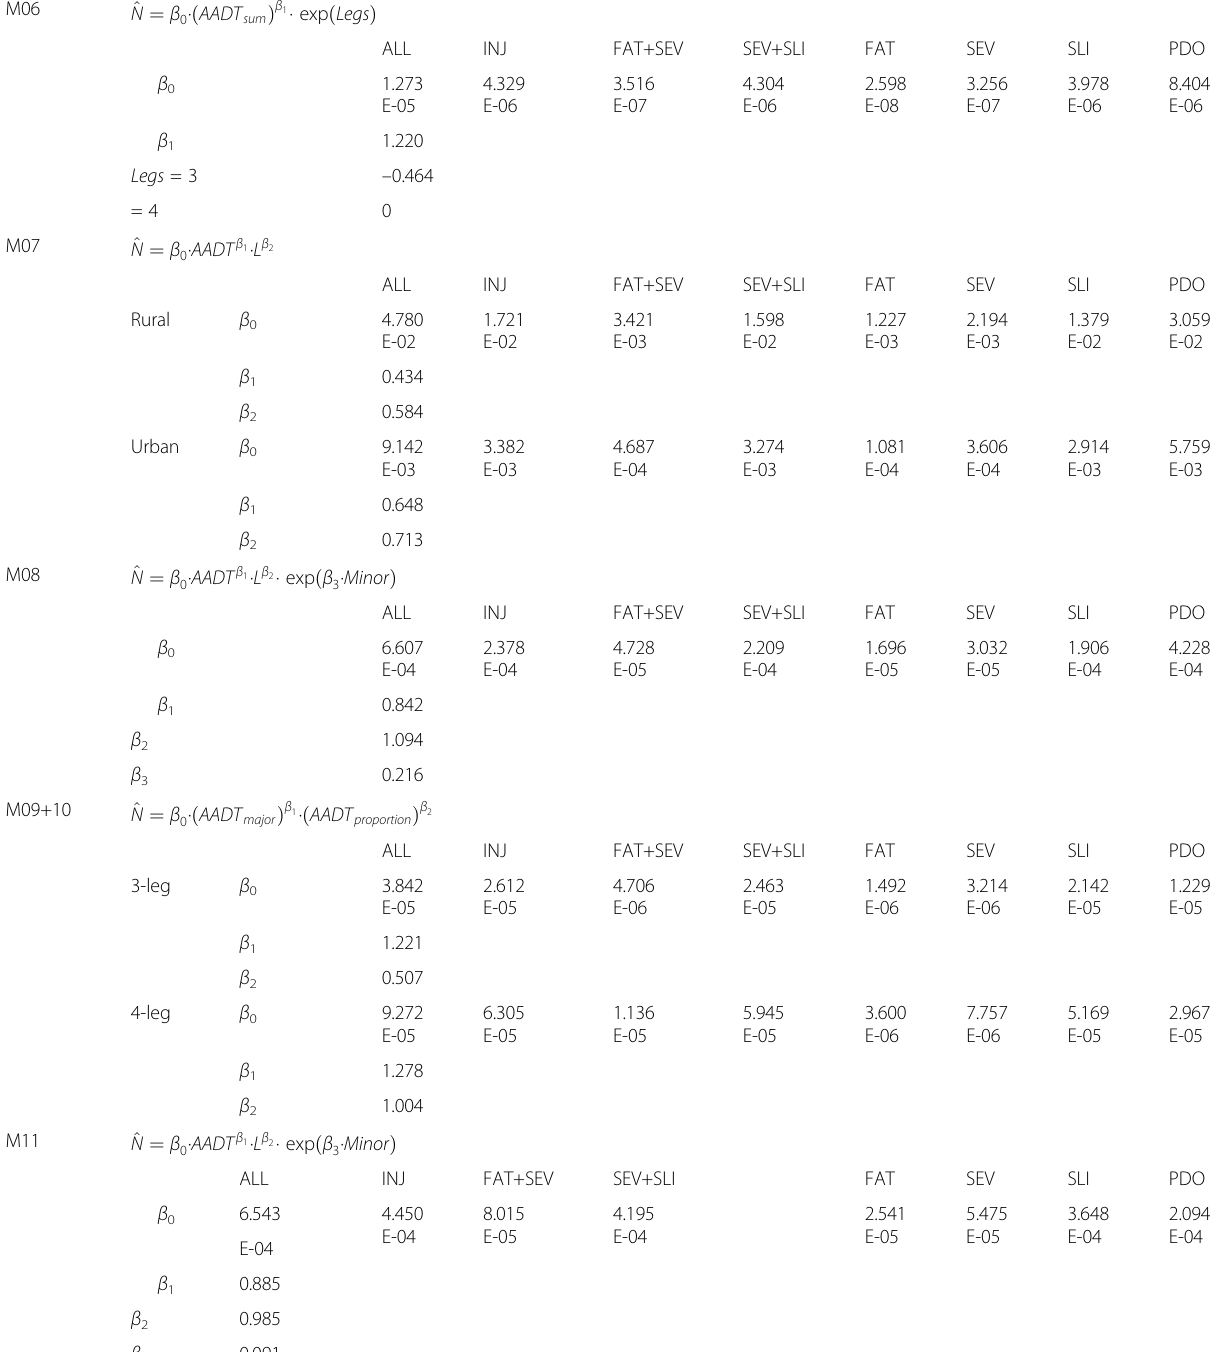
Table 5 Regression parameters of developed accident prediction models